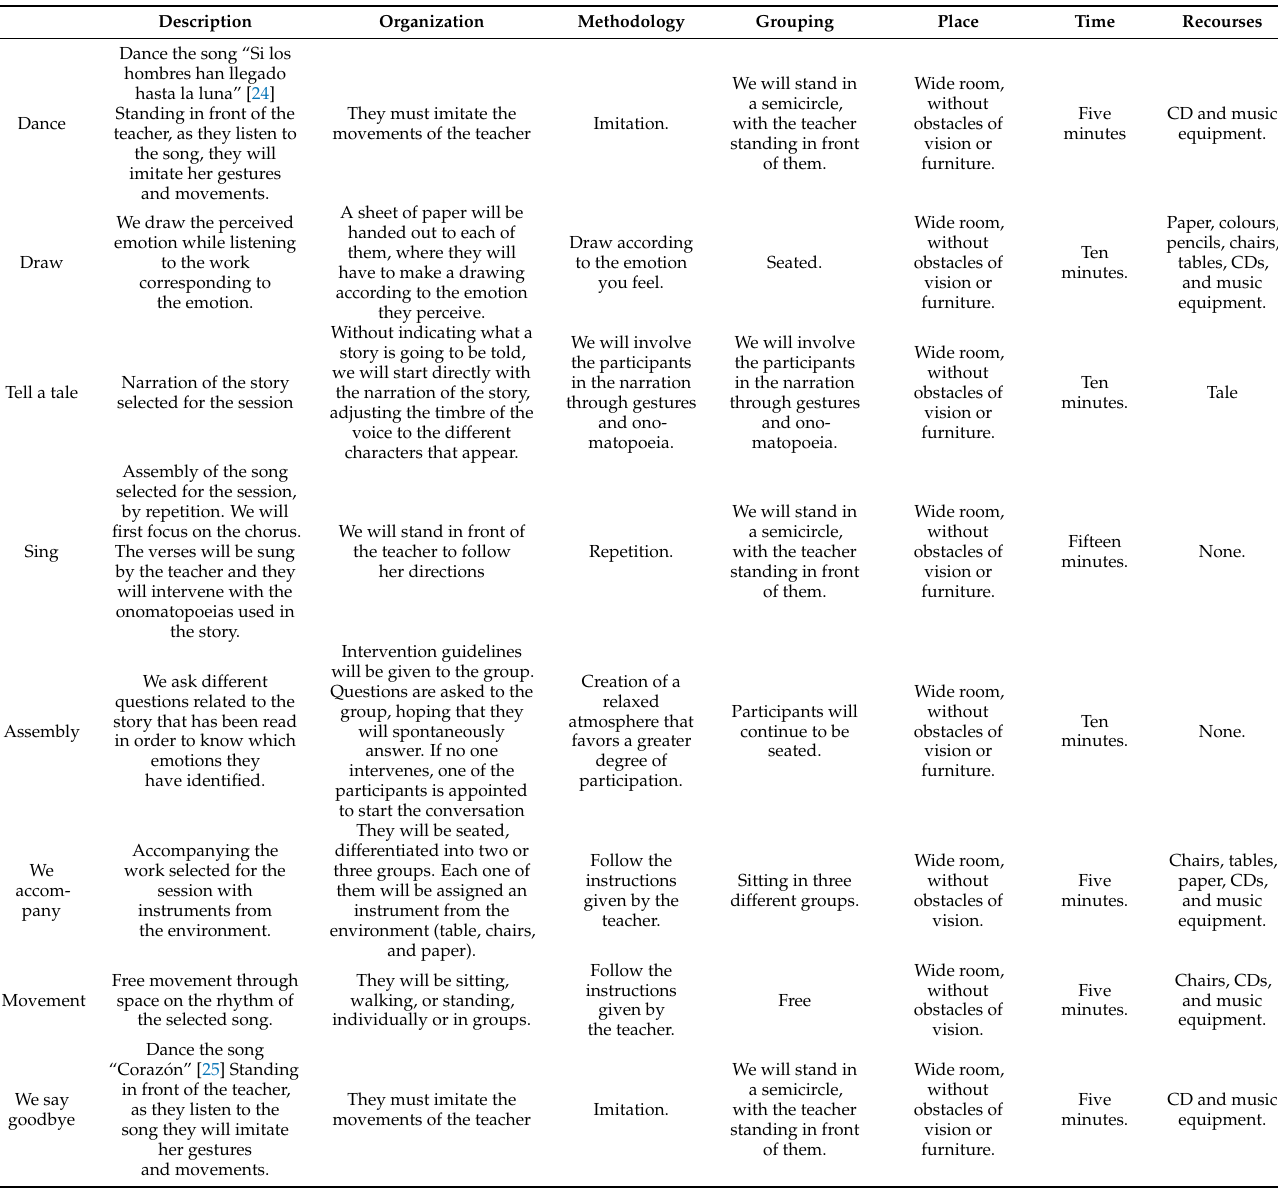
Table 2. Activities developed in the different working